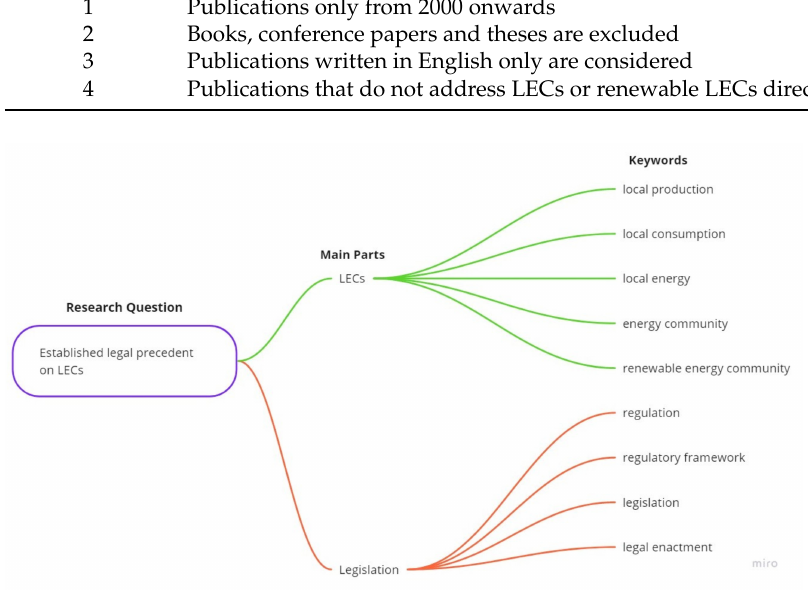
Figure 1. Graphical representation of the keywords targeting the 1st research